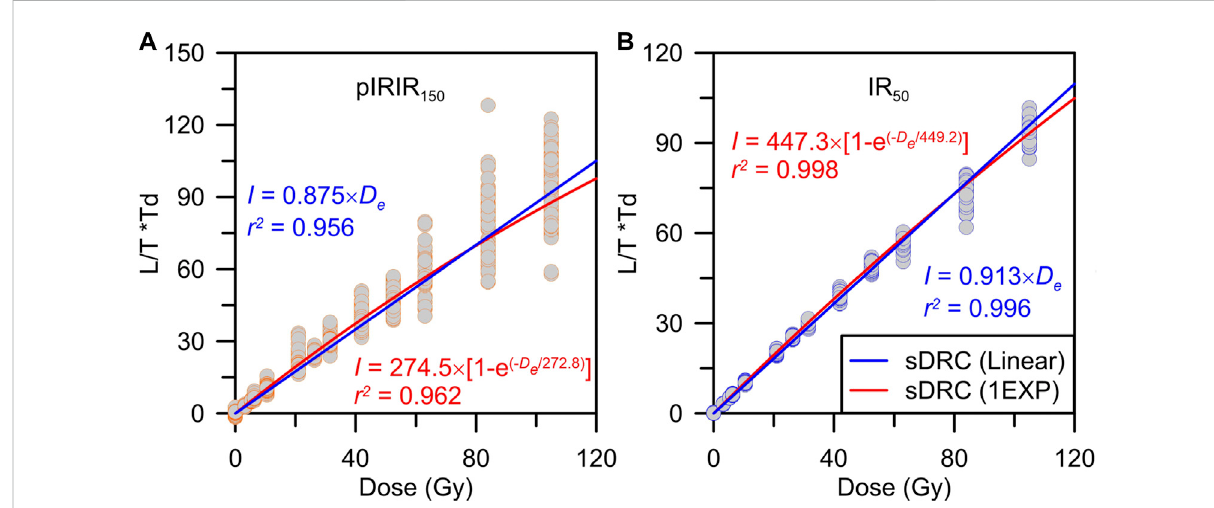
FIGURE 5 sDRC construction using data from all the samples following Roberts and Duller (2004). The sDRCs fi tted using 1EXP and linear functions using the pIRIR 150 (A) and IR 50 (B) data, respectively.